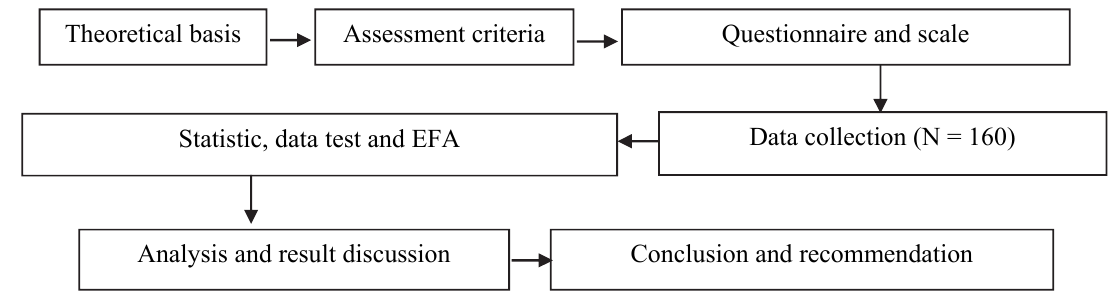
Fig. 1. The structure of the proposed study